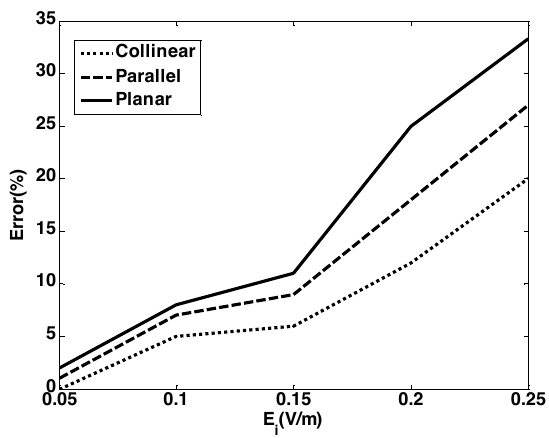
FIGURE 13. Magnitude of induced voltage of infinite planar array of nonlinear antennas under double-tone excitation by the NC and HB techniques under assumption of .